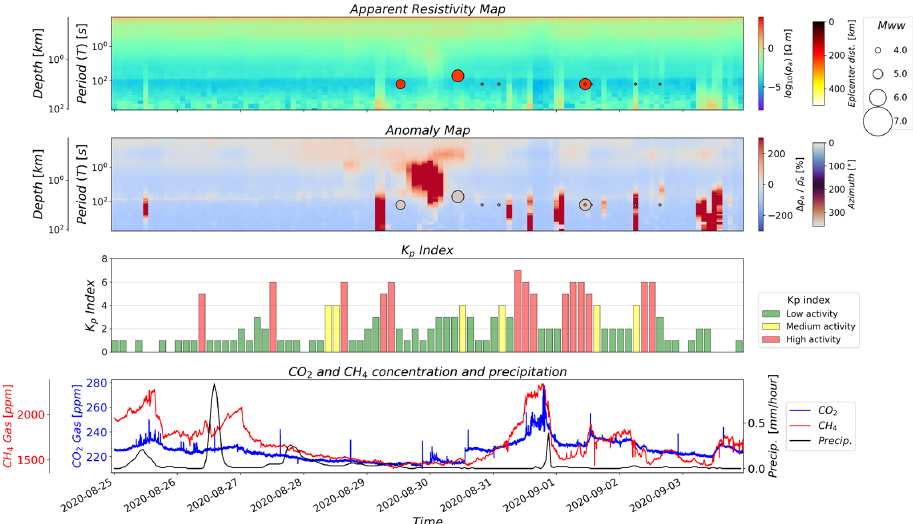
Figure 3. Evolution of the 1D– ρ a structure. The upper panel includes the depth of the hypocentral solutions of earthquakes with m b > 4.0 located in the Bransfield Strait, south of King George Island. The persistent low values of ρ a in shallow depths may correspond to not–well–consolidated permafrost and/or surficial ice cap (upper panel). The second panel shows anomalies of ρ a . Earthquakes reported by the USGS are in the same seismic swarm (epicentral distances and azimuth angles are almost similar). The third panel shows the K p index, suggesting that larger ρ a anomalies (A and N) may not be linked to solar activity. The lower panel shows temporal variations of CO 2 and CH 4 gas emissions. The extremely low precipitation at the Marambio Station does not seem to affect gas concentrations. Precipitation data are taken from https://power.larc.nasa.gov/data--access--viewer/ (accessed on 15 December 2022).